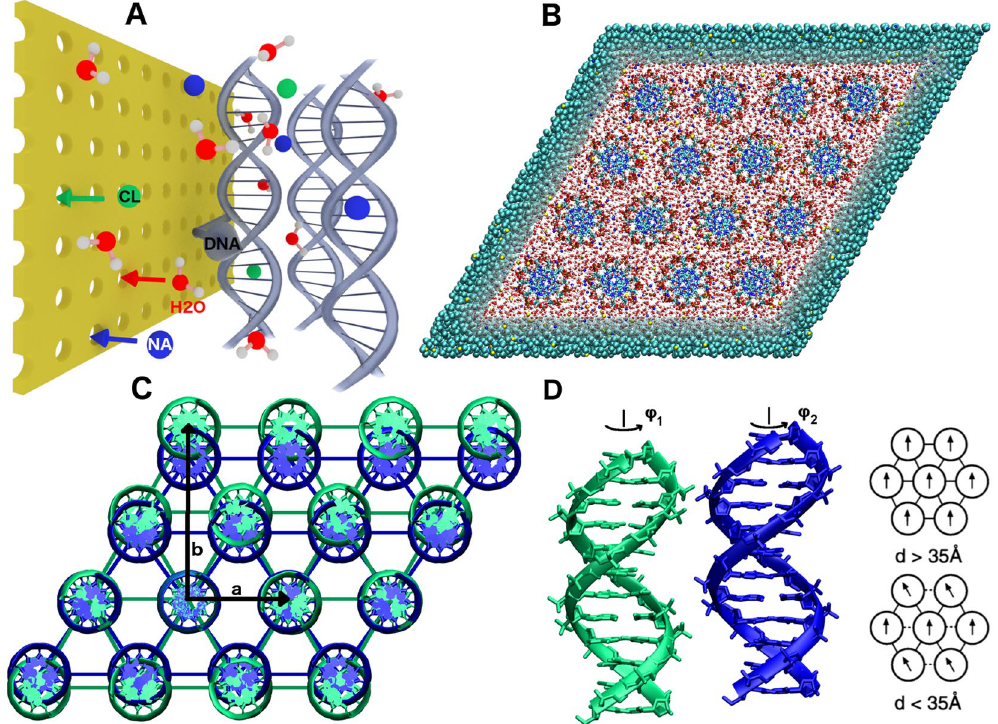
Figure 1. ( A ) Sketch of the simulation setup. An array of DNA molecules is enclosed within the semipermeable membrane, which is permeable to solution molecules (i.e., water, Na + , and Cl − ), but impermeable to the DNA molecules. ( B ) Top-down view of the simulation box containing 16 DNA molecules 3.4 nm long on a hexagonal lattice, to demonstrate the multiscale simulation setup, where the solvent molecules are modeled at two levels of resolution, i.e., the atomistic resolution in the rhombic region containing the DNA molecules and the coarse- grained representation outside. The water molecules and ions (Na + and Cl − ) can change their resolution adaptively on the fly between the atomistic and coarse-grained regions, whereas the DNA array is at all times modeled with the atomistic resolution. To match the experimental setups, the DNA molecules are periodic in the longitudinal direction and thus effectively infinite. ( C ) Superimposed (on DNA molecules in the second row) hex and orto lattices defined by lattice parameters a and b . The ratio b / a of orto phase was set to 1.43. Note, that the angle formed by the DNA array is 60° and 55° for the hex and orto lattices, respectively. The semipermeable membrane enclosing the array is tilted at the same angle as the array. ( D ) Modified from ref. 93: Illustration of an optimal orientation between two DNA molecules, whose orientations are characterized by angles φ and φ . In a densely hexagonally packed DNA array, corresponding to small interaxial spacings d 1 2 between DNA molecules, the nonzero optimal orientational angle between the molecules leads to angular